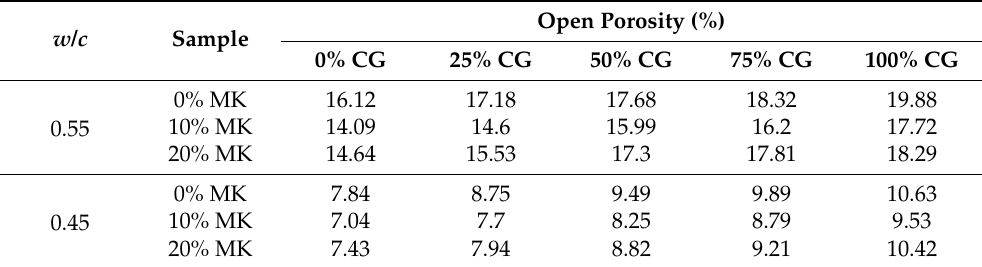
Table 3. Open porosity of the concrete